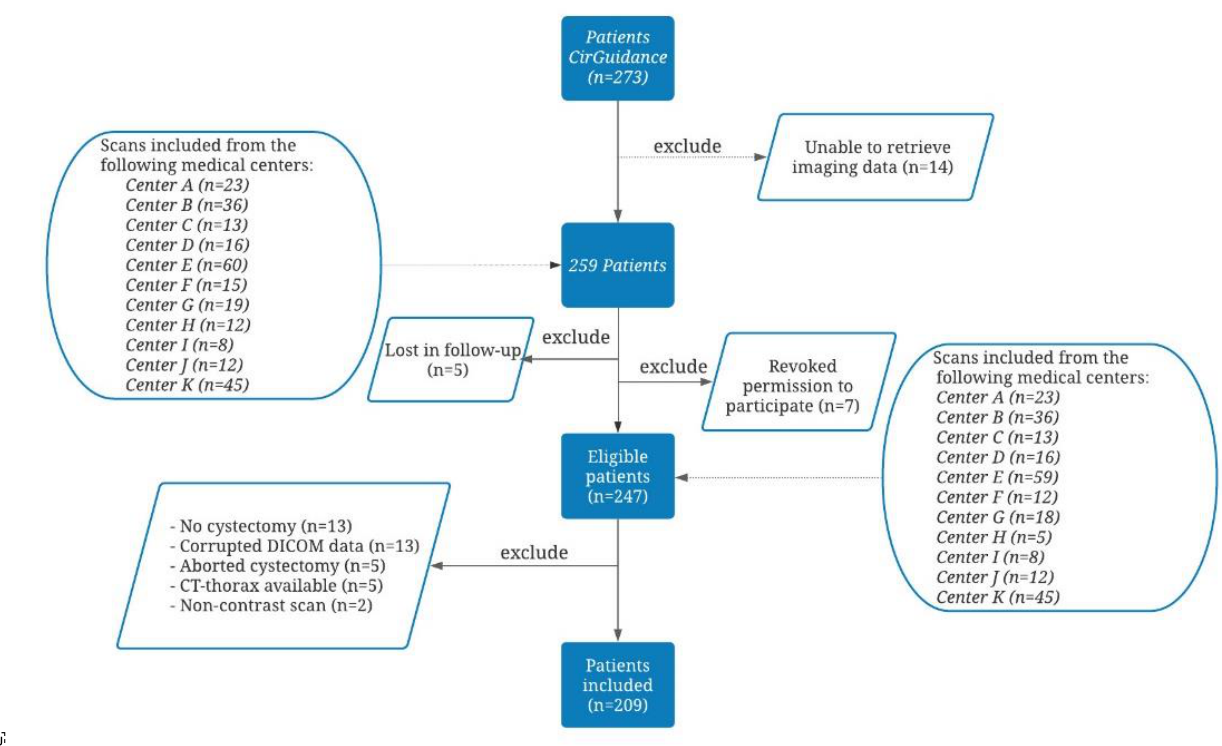
Figure 2. Flowchart of patients included in our post hoc analysis of the CirGuidance trial [33]. Reasons for exclusion were: lost to follow-up ( n = 5), revoked permission to participate ( n = 7), no cystectomy ( n = 13), corrupted DICOM data ( n = 13), aborted cystectomy ( n = 5), CT-thorax provided ( n = 5) or non-contrast scan ( n = 2). In the end, 209 patients were included in this study. Clinical and imaging characteristics of the included patients are reported in Table 1. A total of 37 patients were excluded because of the following: no cystectomy ( n = 13), aborted cystectomy ( n = 5), corrupted DICOM data ( n = 13), only CT of chest available ( n = 5) and non-contrast CT scan ( n =